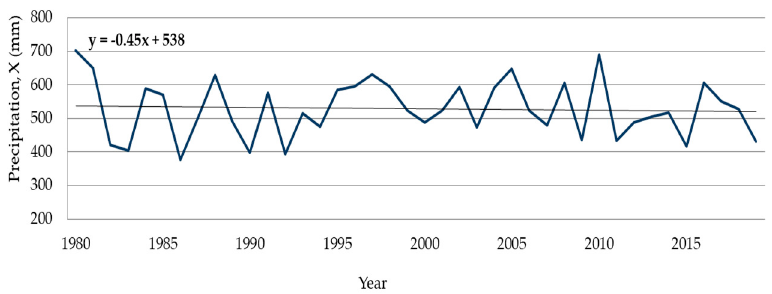
Figure 11. The sum of annual precipitation, averaged over the Middle and Lower Dniester basin in the 1980–2020 years.